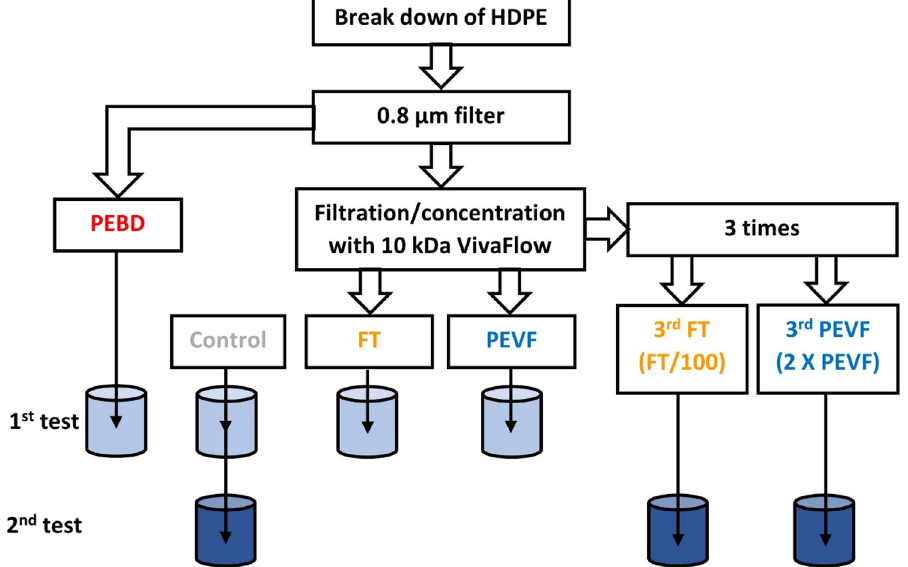
Figure 1. Scheme of HDPE break down process. Two grams of HDPE is mechanically broken down in water using a food blender. The water is and filtrated through a 0.8 um filter. In the 1st test the nanoplastics are concentrated and separated from smaller molecules using a VivaFlow device with a molecular weight cut off 10 kDa and the toxicity of each fraction and control was tested on D. magna . In the 2nd test the nanoparticles are purified from smaller molecules through repeated (three times) concentration and dilutions. At the end the PEVF is concentrated two times and the smaller molecules in PEVF and FT less than 1% compared to in 1st toxicity